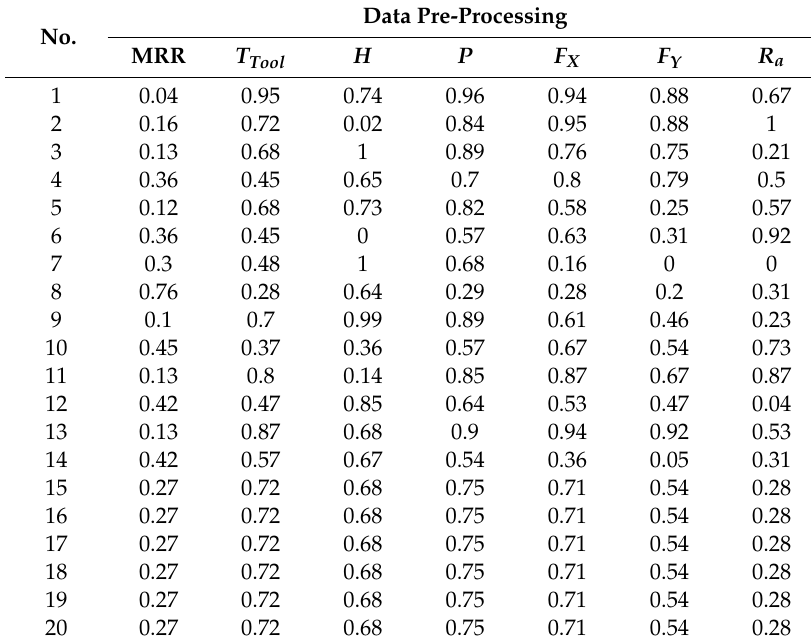
Table 6. Data pre-processing for Trial 1.